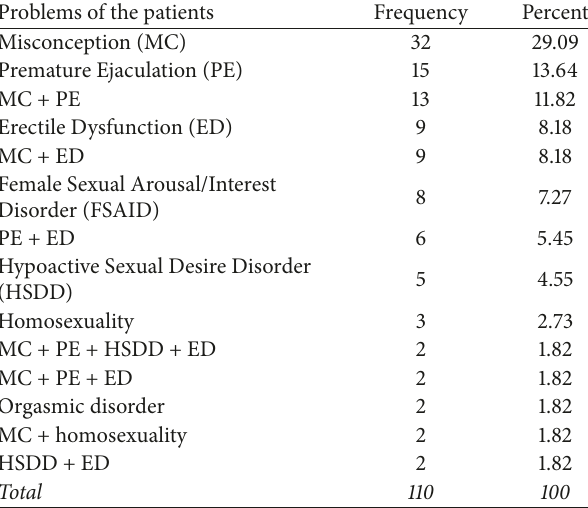
Table 2: Distribution of problems among the respondents ( 𝑛 = 110 ).